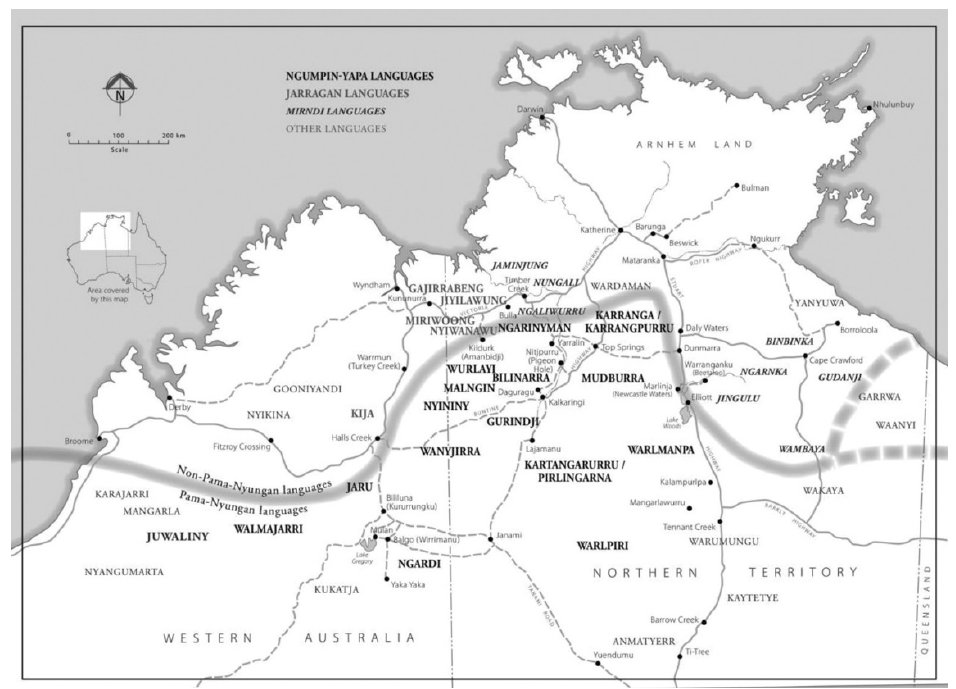
Figure 1. Ngumpin-Yapa and surrounding languages (Meakins and Pensalfini (2020): map drawn by Brenda Thornley (2017)). Brenda Thornley